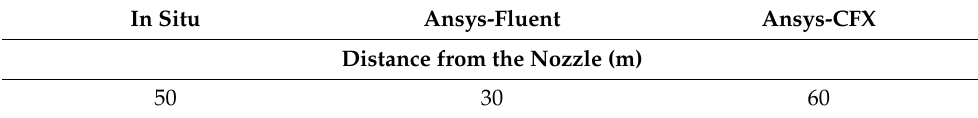
Table 6. Results of the path length of aerosols during in situ tests and CFD calculations. In